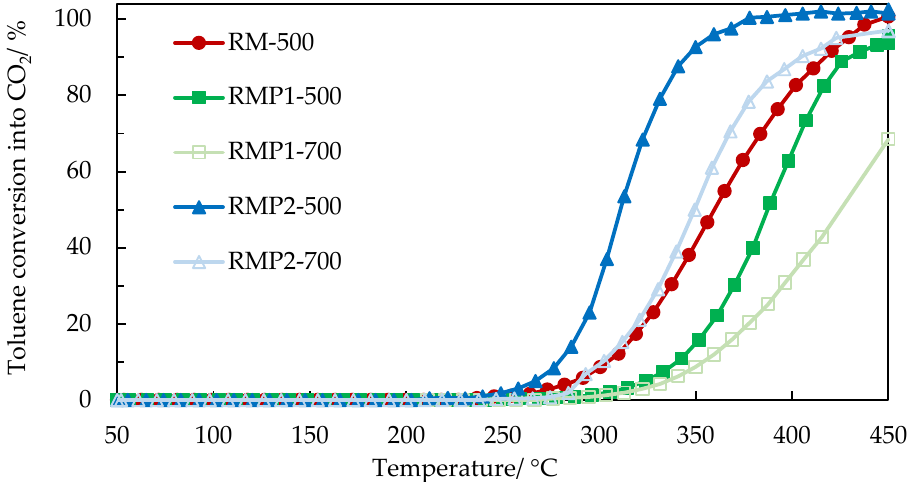
Figure 12. H 2 -TPR profiles of precipitated red mud samples calcined at 500 °C and 700 °C.